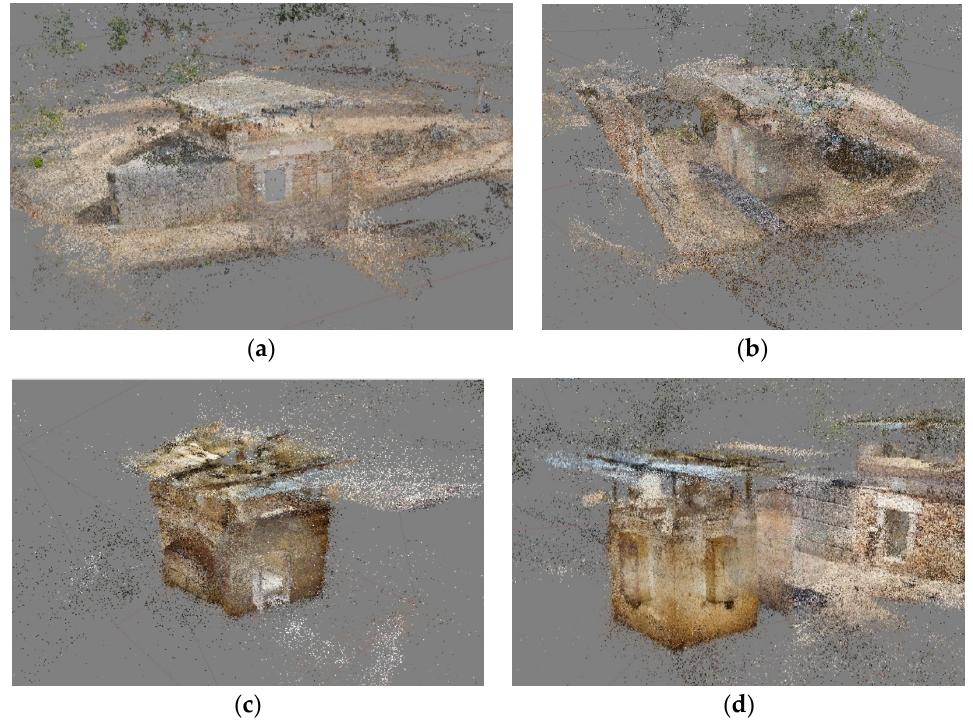
Figure 9. Scattered point cloud generated independently for each block into which we divided our working environment. ( a ) Sparse point cloud of the exterior of the Niger and Julios buildings (01_EXT_N-J). ( b ) Sparse point cloud of the exterior of the Voconios building (02_EXT_V). ( c ) Sparse point cloud from inside Niger and Julios buildings (03_INT_N-J). ( d ) Sparse point cloud of the interior of the Voconios building (04_INT_V).